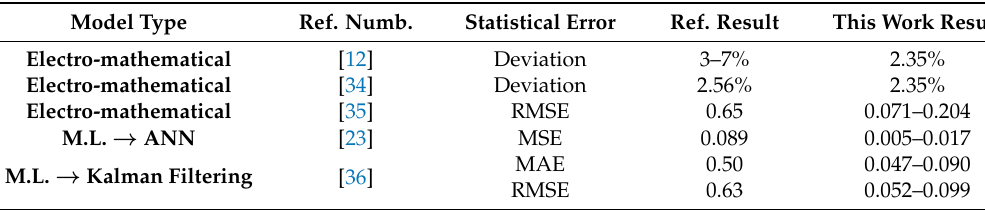
Table 6. Comparison between this work and other model. Model